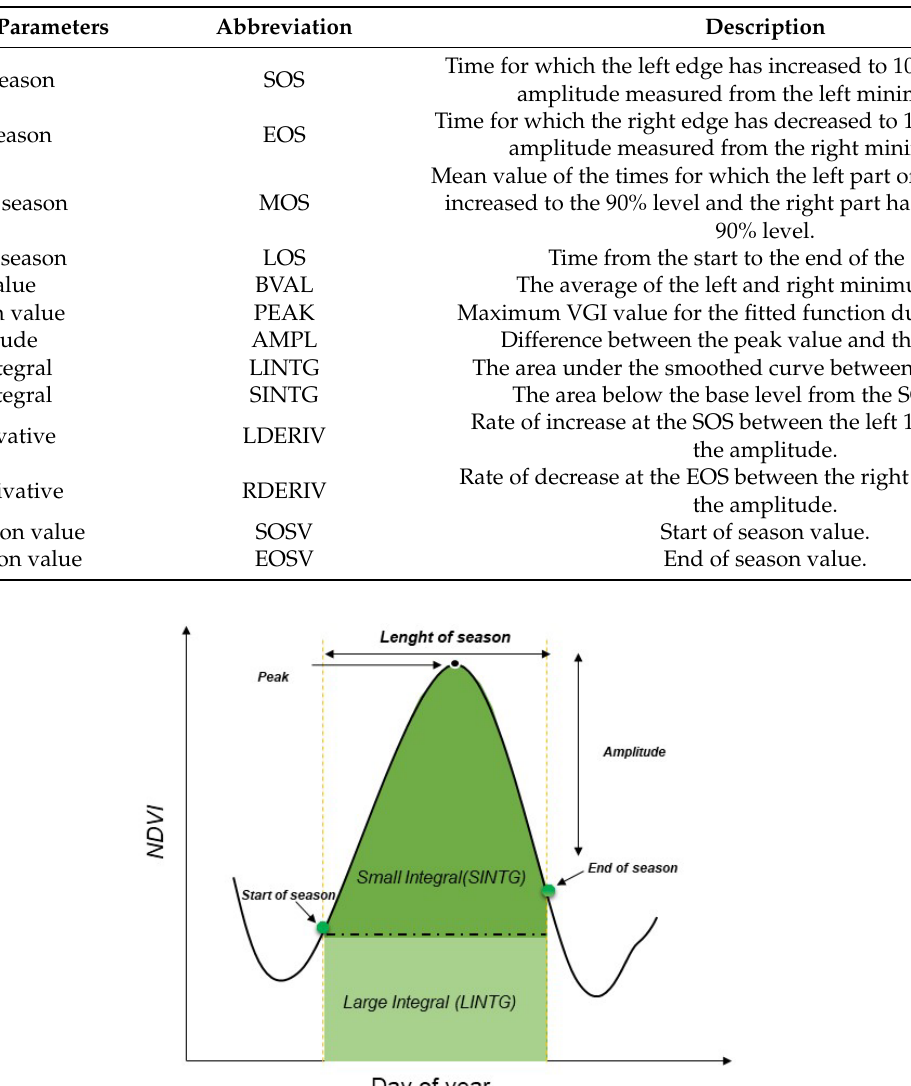
Table 2. Seasonality parameters in TIMESAT.